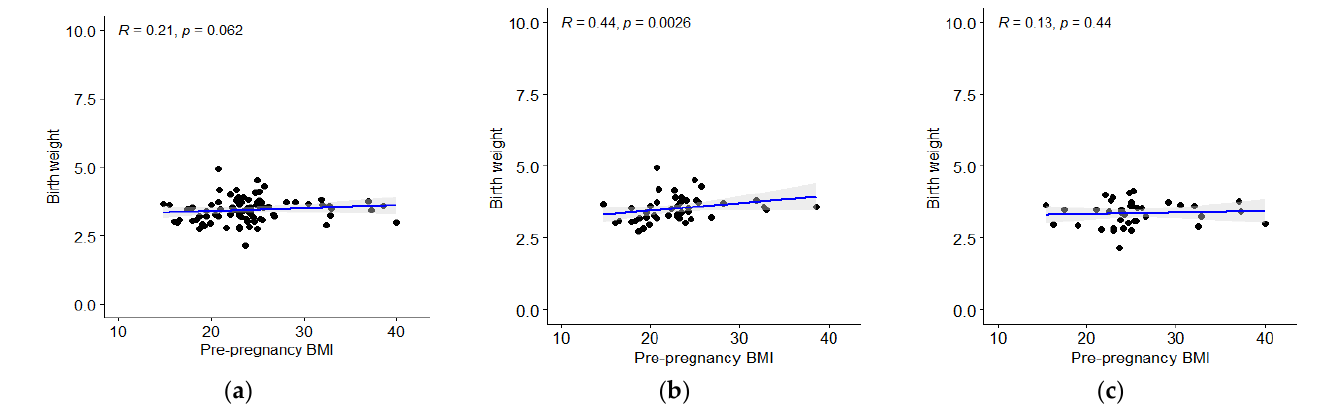
Figure 1. ( a ) The correlation between mother’s pBMI and child’s birth weight; ( b ) correlation between mother’s pBMI and birth weight of male population; ( c ) correlation between mother’s pBMI and weight of female population.